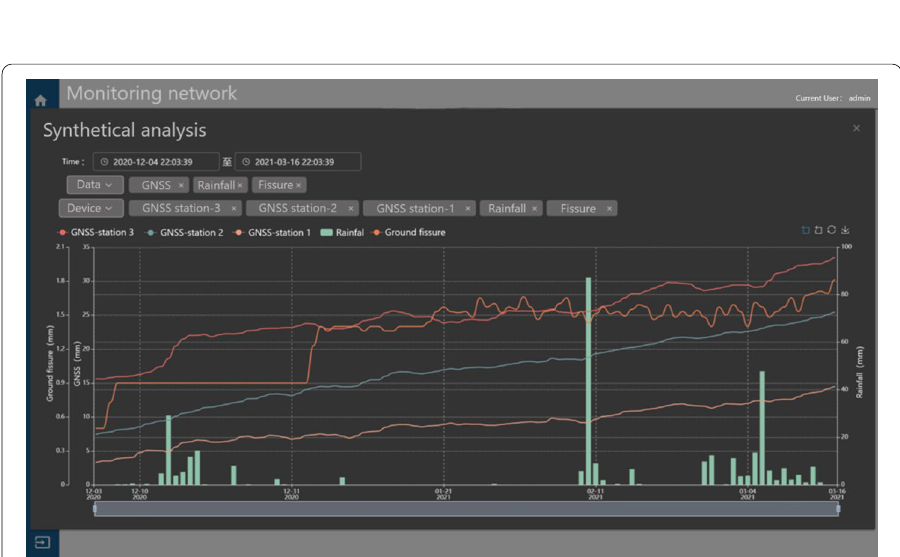
Fig. 11 GNSS 3D surface displacement and rainfall monitoring data map (December 4, 2020 to March